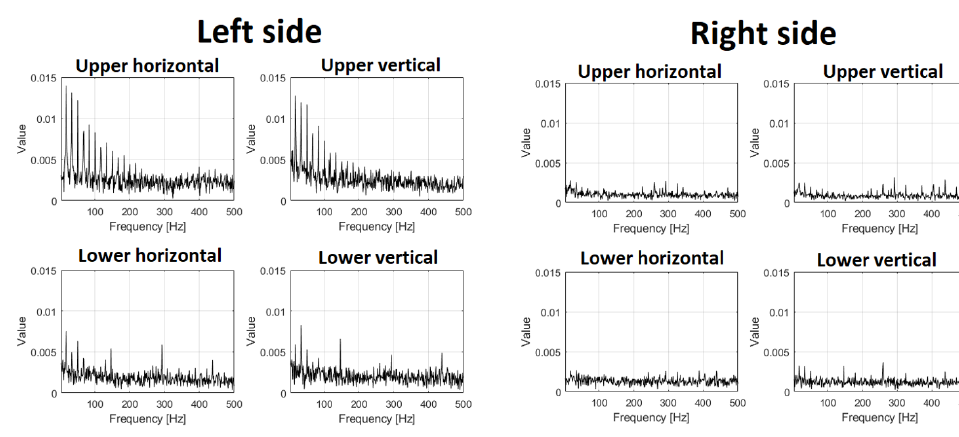
Figure 12. Envelope spectrum before repair.